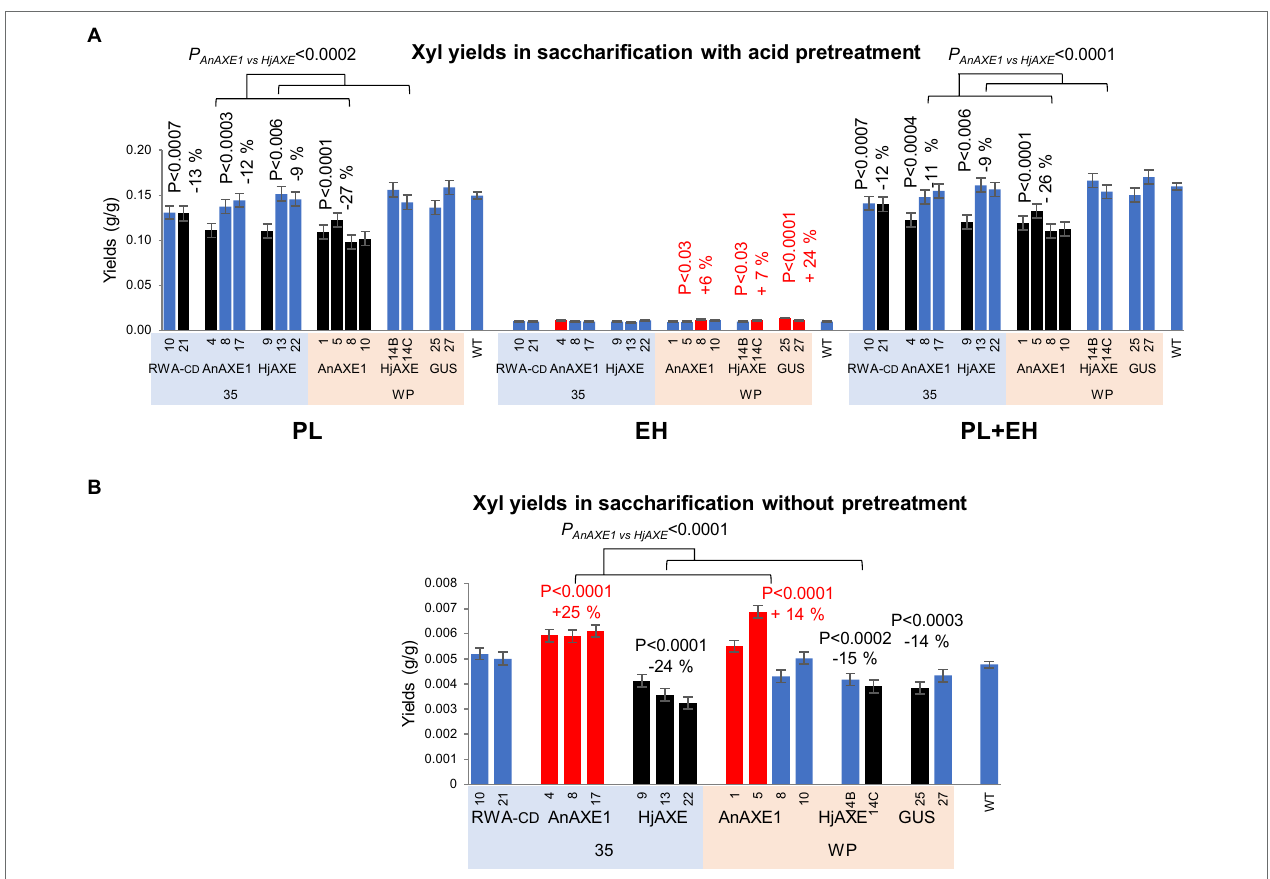
FIGURE 5 | Saccharification parameters of transgenic five-year-old field-grown aspen (xylose yields). (A) Xylose yields in saccharification with acid pretreatment. PL, pretreatment liquid; EH, enzymatic hydrolysis; and PL + EH, total sugar yield. (B) Xylose yields in saccharification without pretreatment. Means ± SE . Significant differences according to ANOVA followed by Dunnett’s test ( p < 5%) are indicated by color (red – higher and black – lower, than WT parameters). The values of p show the significance of differences between all the lines carrying indicated constructs and WT plants (post-ANOVA contrast, shown when < 5%). Effects of the transgene ( AnAXE1 vs. HjAXE ) were assessed by ANOVA F-